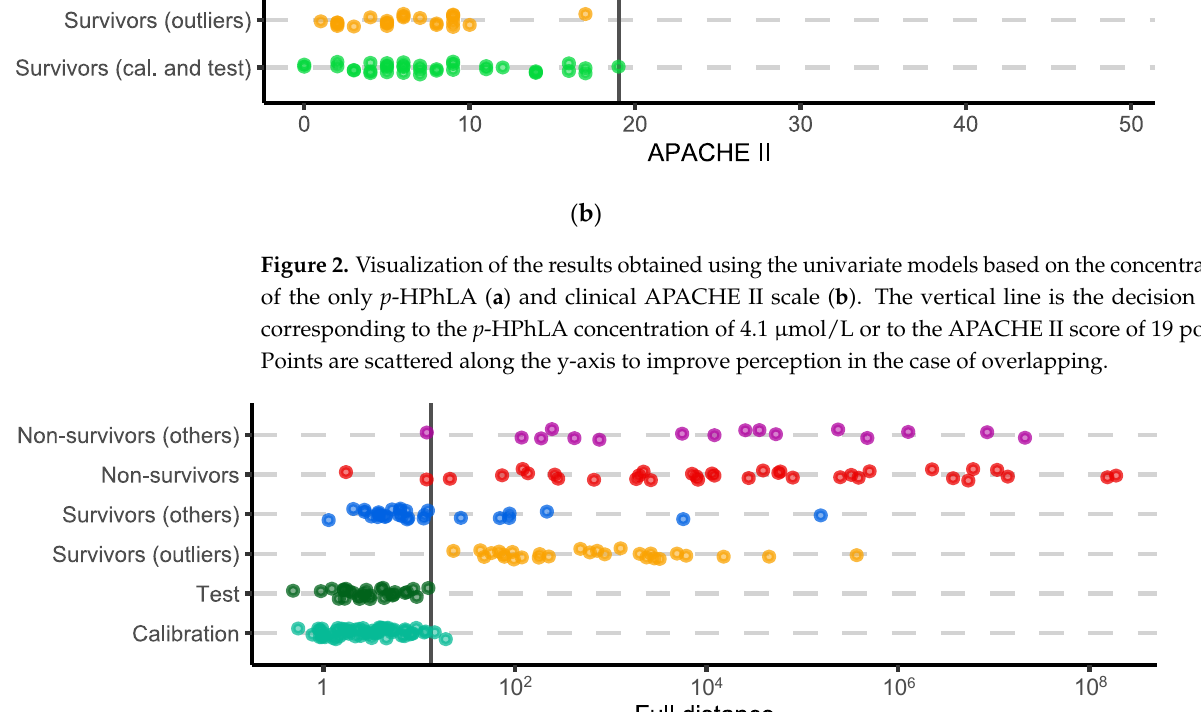
Figure 4. ROC curves obtained for univariate models based on the p -HPhLA concentration and clin- ical APACHE II scale, and multivariate models based on the profile of the 8 aromatic metabolites, including p -HPhLA, and on the profile of the 7 aromatic metabolites without p -HPhLA.